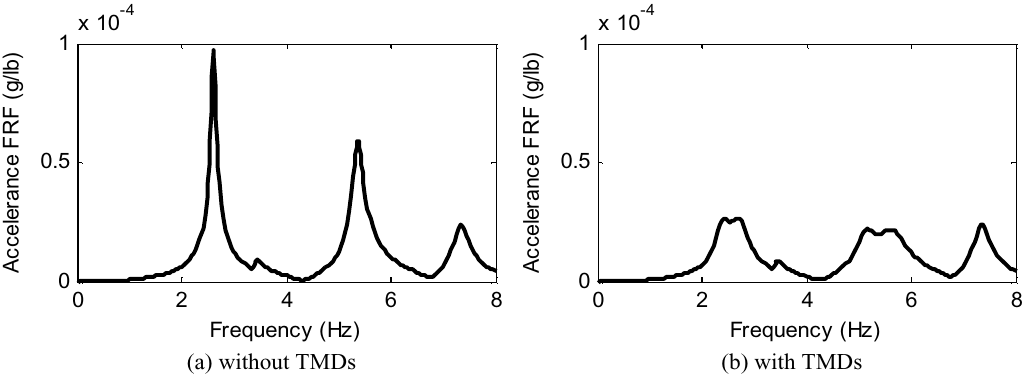
Fig. 4. Floor point accelerance FRF at R1 and 2 without and with TMDs.